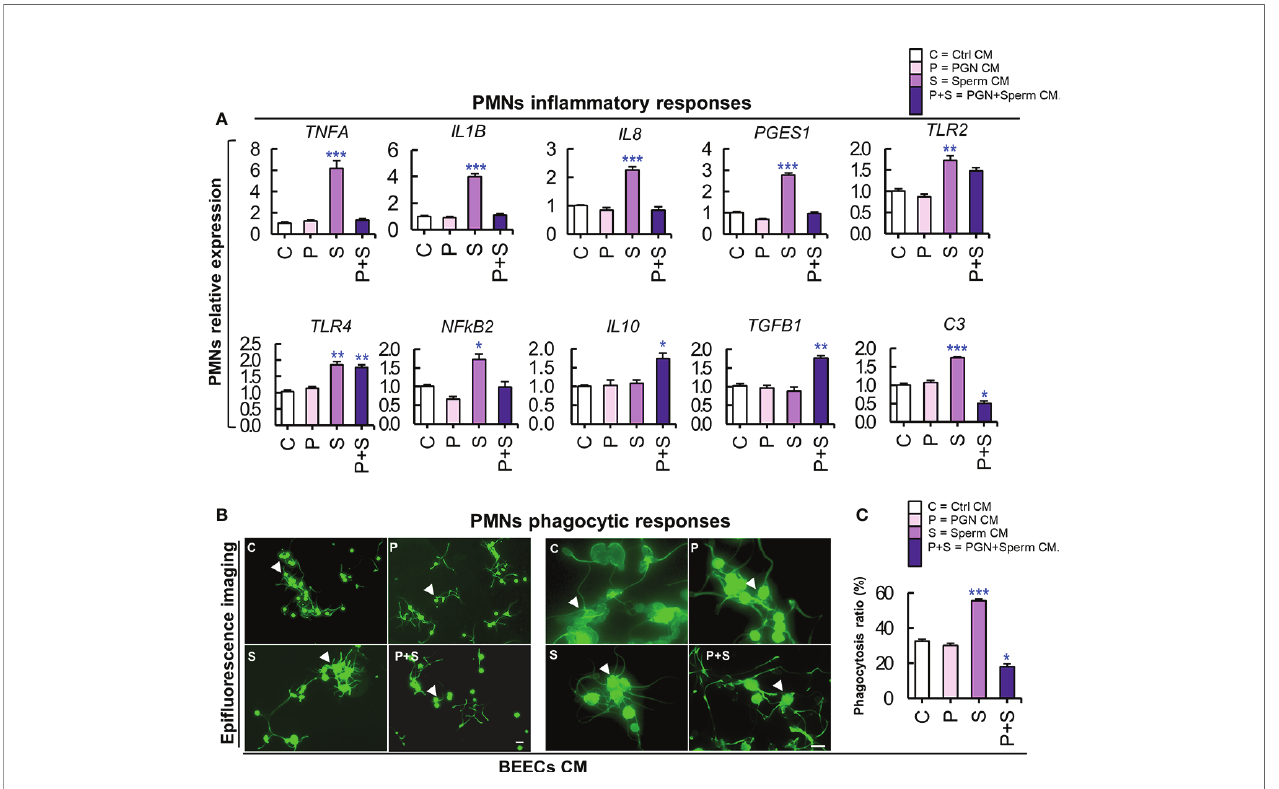
FIGURE 6 | (A) PGN suppressed the stimulatory impact of sperm-BEECs conditioned media on the transcription of major pro-and anti-in fl ammatory genes of PMNs in vitro . Mature PMNs (7×10 6 cells ml − 1 ) isolated from circulating blood of healthy cows were challenged for 2 h in CM obtained from BEECs, exposed to PGN (10 pg ml − 1 ) for 24 h, washed, and co-cultured with sperm for 6 h. The mRNA expression of different genes was quanti fi ed using RT-PCR assay. Data are presented as mean ± SEM of 3 independent experiments where asterisks denote a signi fi cant variance (*P<0.05 or **P<0.01) between the different groups when compared to the control group. (B) PGN downregulated the stimulatory impact of sperm-BEEC conditioned medium on phagocytic activity of PMNs. Similarly, mature PMNs (7×10 6 cells ml − 1 ) were challenged in this CM for 2 h followed by co-culture with sperm (7×10 6 cells ml − 1 ) for 1 h and phagocytosis was assessed. (B) Representative images of PMN phagocytosis for sperm. Magni fi cation: 200× (left? panel) and 400× (right panel). (Control; C, PGN; P, sperm; S, and PGN + sperm; P+S). Arrow heads indicate PMNs phagocytosing sperm. Scale bar=20 m m. (C) The phagocytosis ratio was independently assessed by two observers for 1000 cells using an all in one epi fl uorescence high-resolution imaging system (Keyence, BZ-X800, Osaka, Japan). Results are representative of 3 independent trials using 3 different healthy animals. Data are presented as mean ± SEM with asterisk denoting a signi fi cant variance (*P<0.05 ) between the different groups when compared to the control group. Asterisk denotes a signi fi cant variance (*P<0.05) between the ‘ Sperm ’ and ‘ PGN+Sperm ’